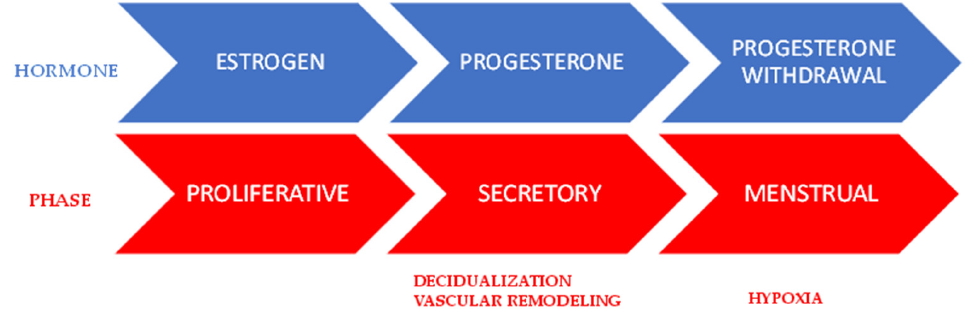
Figure 3. Timeline of hormone production and different phases during the menstrual cycle in humans. Figure generated using PowerPoint.